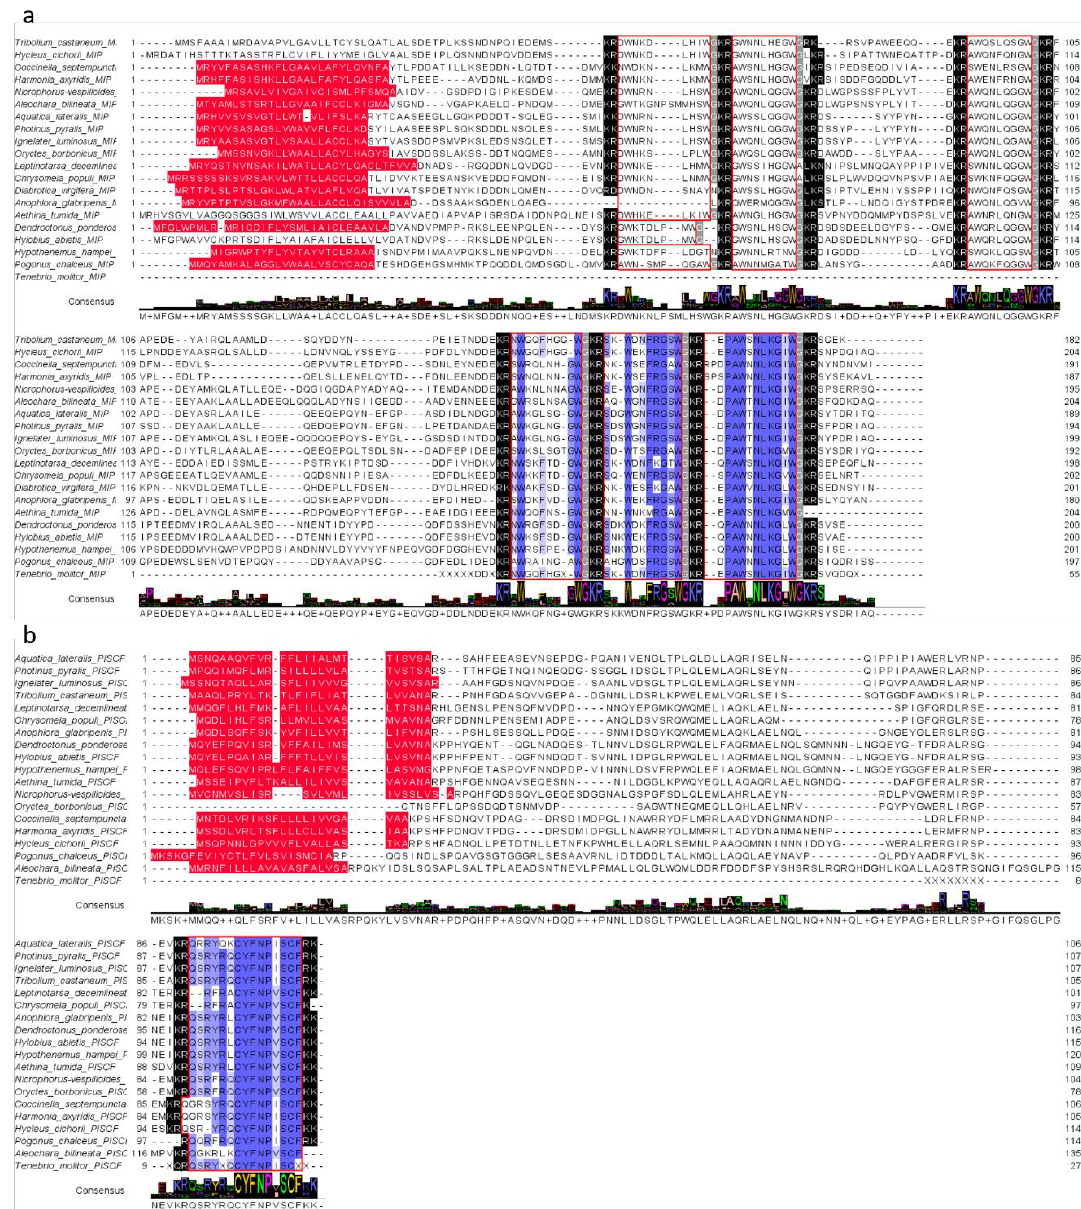
Figure 2. Alignment of putative MIP/AST ( a ) and PISCF/AST ( b ) sequences in beetle species and their consensus sequences with T. molitor identified sequences in this study. The blue color indicates similarities in the amino acid sequence. Red color—signal peptides at N-termini; black indication—endopeptidase cleavage sites; gray—amidation sites; red frames = the other deduced MIP isoforms.